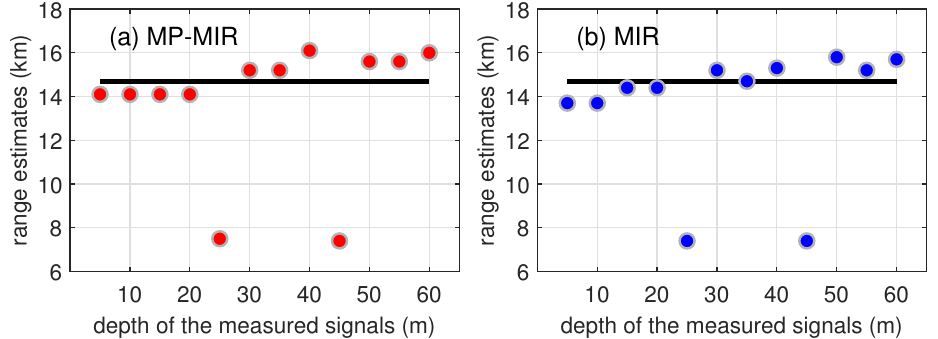
Figure 4. Ranging results of 12 “measured” signals. Black horizontal lines represent the true range of 14.7 km.